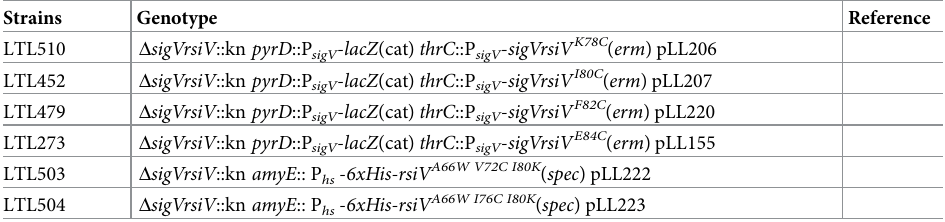
cells. Oligonucleotide primers used for PCR and site-directed mutagenesis are listed in S1 Table. Constructs were cloned into pDR111 in order to place rsiV variants under control of the IPTG-inducible hyper-spank (P ) promoter. The vector, pDR111 was digested with HindIII hs and SphI and PCR products were introduced by isothermal assembly. All pDR111 constructs were transformed into CDE1563 ( Δ sigVrsiV :: kn ) and the RsiV construct was introduced at the amyE gene on the chromosome. WT RsiV was created using CDEP3194/CDEP3195 (chromo- somal DNA). Rsiv-GFP fusion construct inserts were created using CDEP3865/Appropriate RsiV-GFP Reverse (Rev) primer (chromosomal DNA) and CDEP3868/Appropriate RsiV-GFP Forward (For) primer (pCM11 template) [62]. RsiV deletion constructs were created using CDEP3194/Appropriate RsiV Δ Rev primer (chromosomal DNA) and CDEP3195/Appropriate RsiV Δ For primer. SCAM constructs were created by first building 6xHis-rsiV A66W using primers CDEP3629/A66W Rev (chromosomal DNA) and CDEP3195/A66W For (chromo- somal DNA). The remaining SCAM constructs were created using 6xHis-rsiV A66W as tem- plate. The inserts were created with primers CDEP3629/Appropriate rsiV For primer and CDEP3195/Appropriate rsiV Rev.